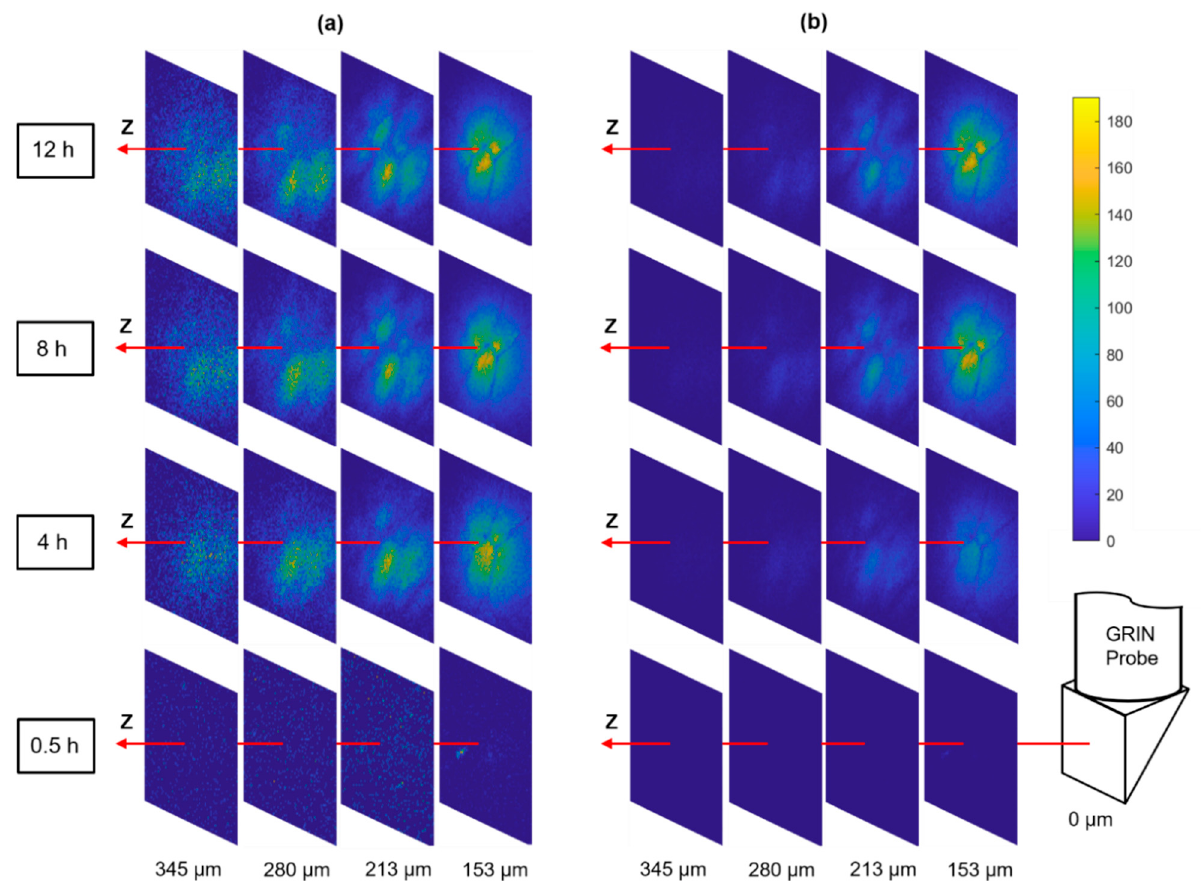
Figure 5. Optical sectioning of the local drug delivery process in tumor. The same images are displayed with ( a ) individual color bars (not shown) for better visualization of the microstructure and ( b ) a common color bar for direct comparison of signal level.